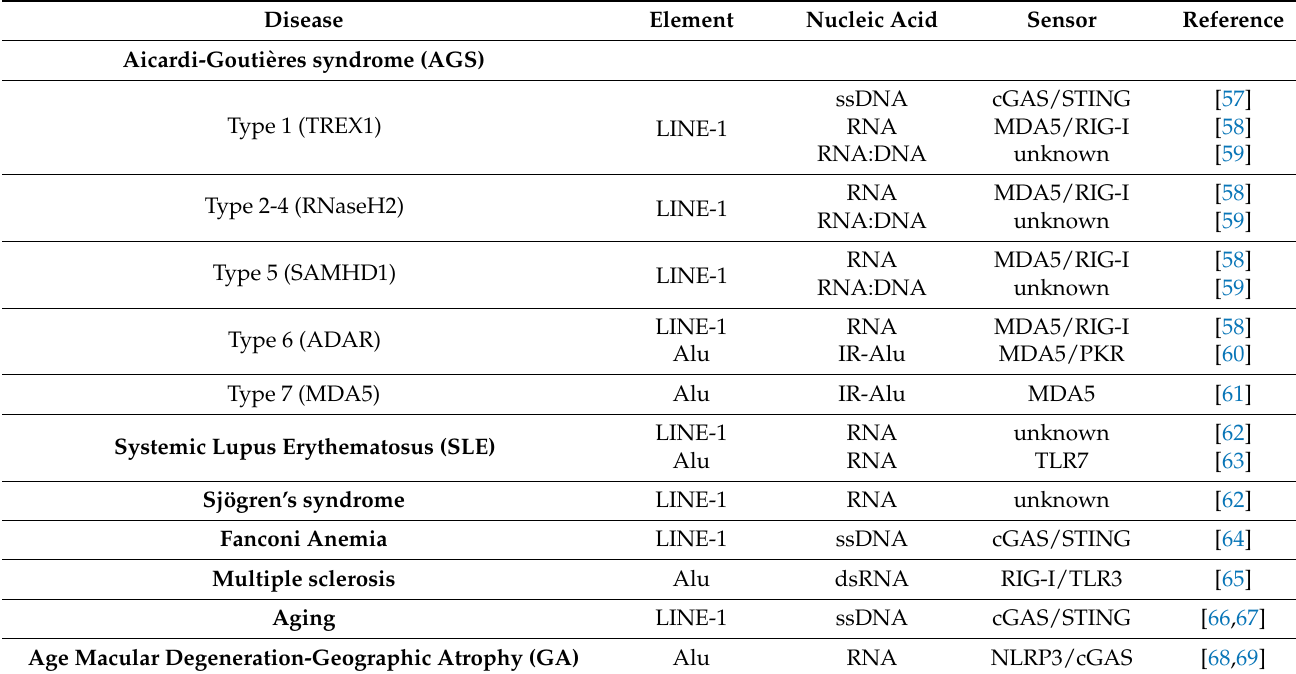
Table 1. Innate sensing of molecular patterns in non-LTR retrotransposons and its potential role in autoinflammatory